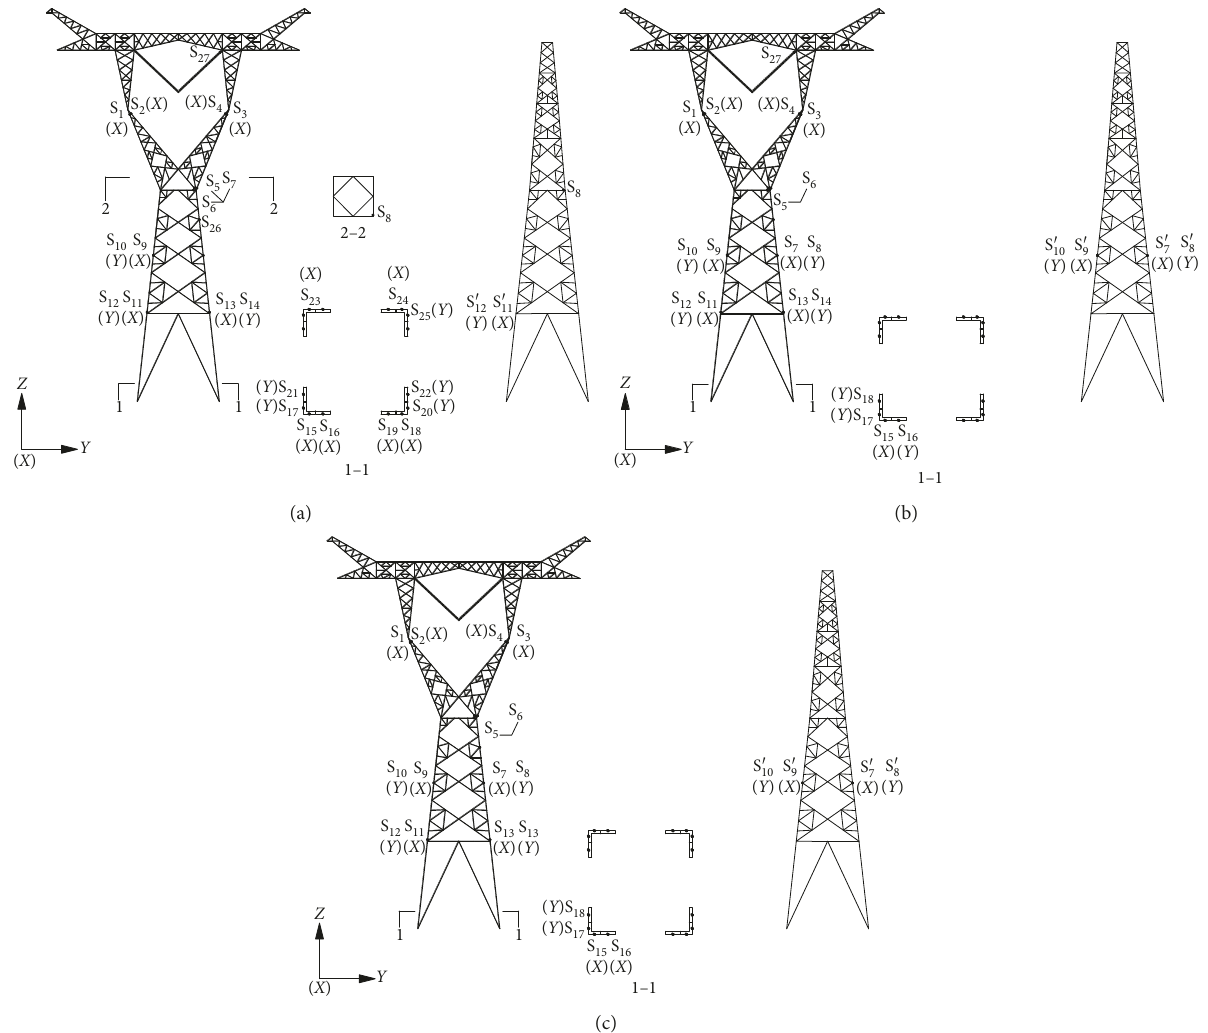
Figure 20: Layout of the strain gauges on the five-tower-four-line model. (a) Layout of 28 strain gauges on the middle tower. (b) Layout of 23 strain gauges on the right main tower. (c) Layout of 22 strain gauges on the left main